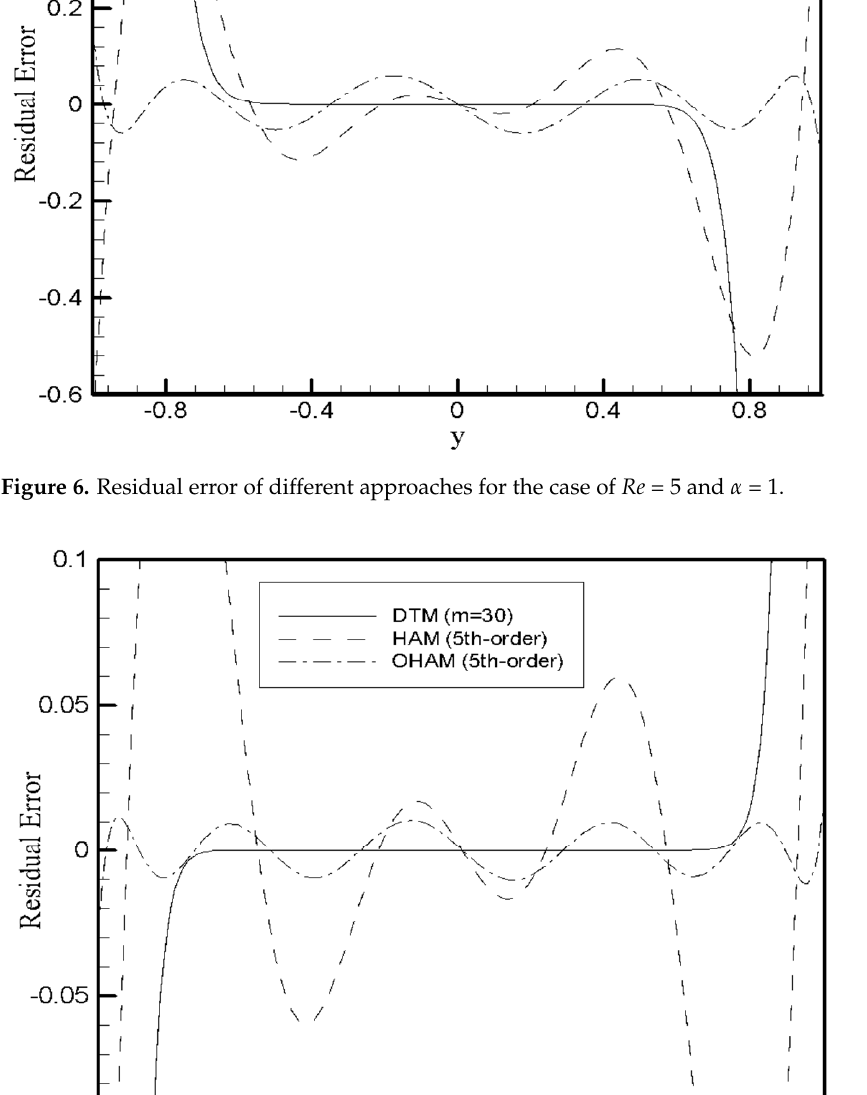
Figure 8. Behavior of f ( y ) with variation of Re simulated by numerical simulation, ADM and VIM.